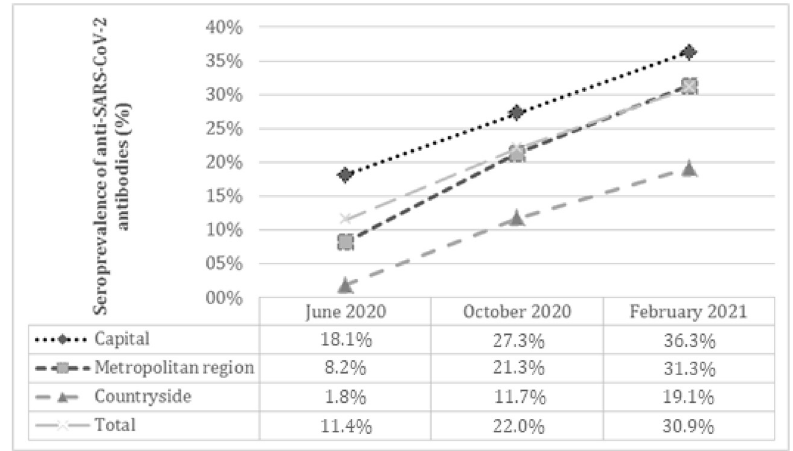
Fig. 1. Univariate analysis of the seroprevalence of anti-SARS- CoV-2 antibodies in the three periods evaluated and according to the blood donation sites. The seroprevalence for the whole group and according to the blood donation sites increased over time, and comparisons by qui-square test showed statistical sig- ni fi cance ( p <